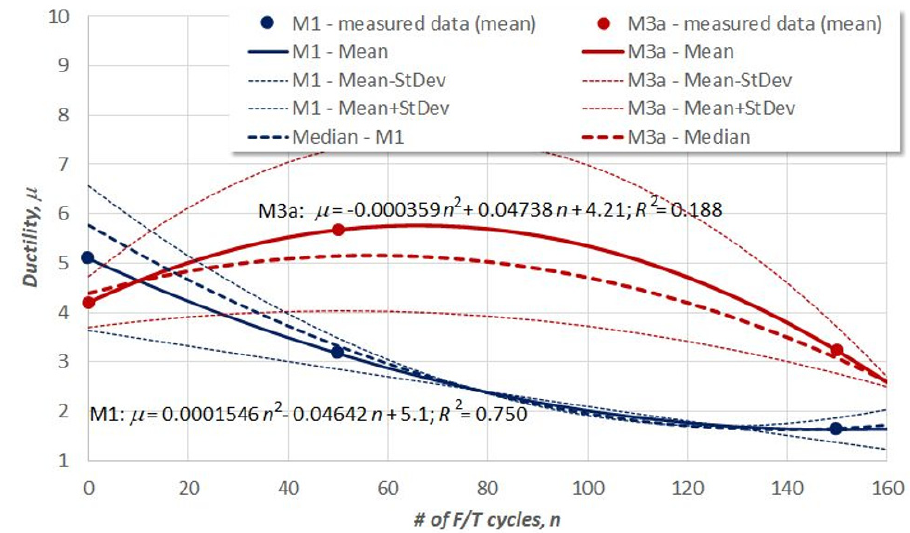
Figure 2. Mean and Mean ± Standard deviation regression curves for ductility, µ , for two types of mortar. Dashed line represents Median. Corresponding expressions for Mean are also presented.